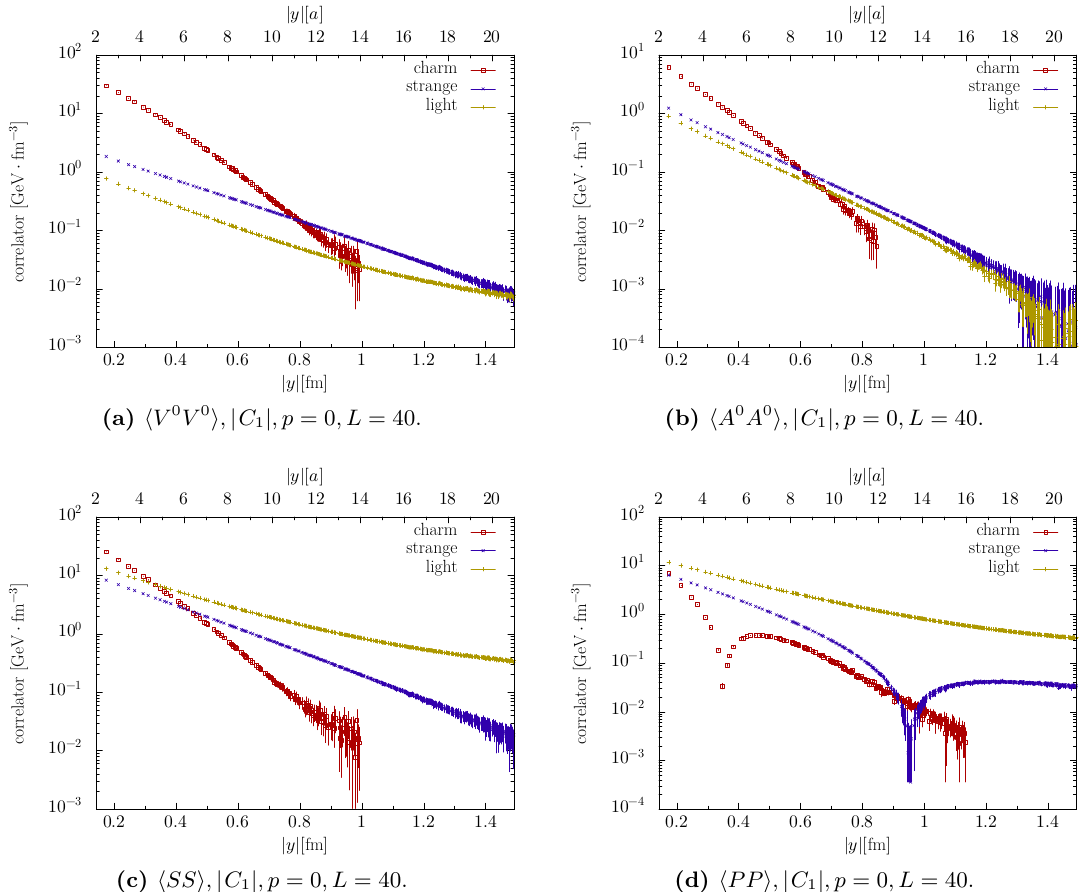
Figure 12. Comparison of C 1 for the three di(cid:11)erent quark masses of our study. For clarity, we j j have omitted data points for which the statistical error is too large compared with the central